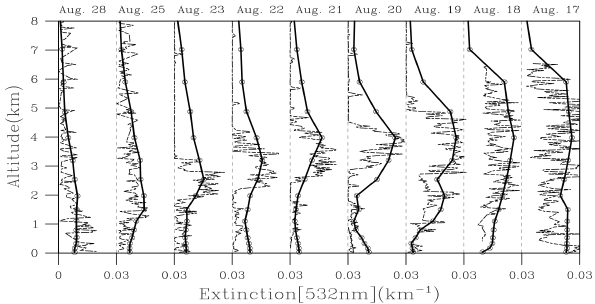
Fig. 10. Comparison of vertical distribution of Saharan dust be- tween model simulations and CALIPSO observations in August of